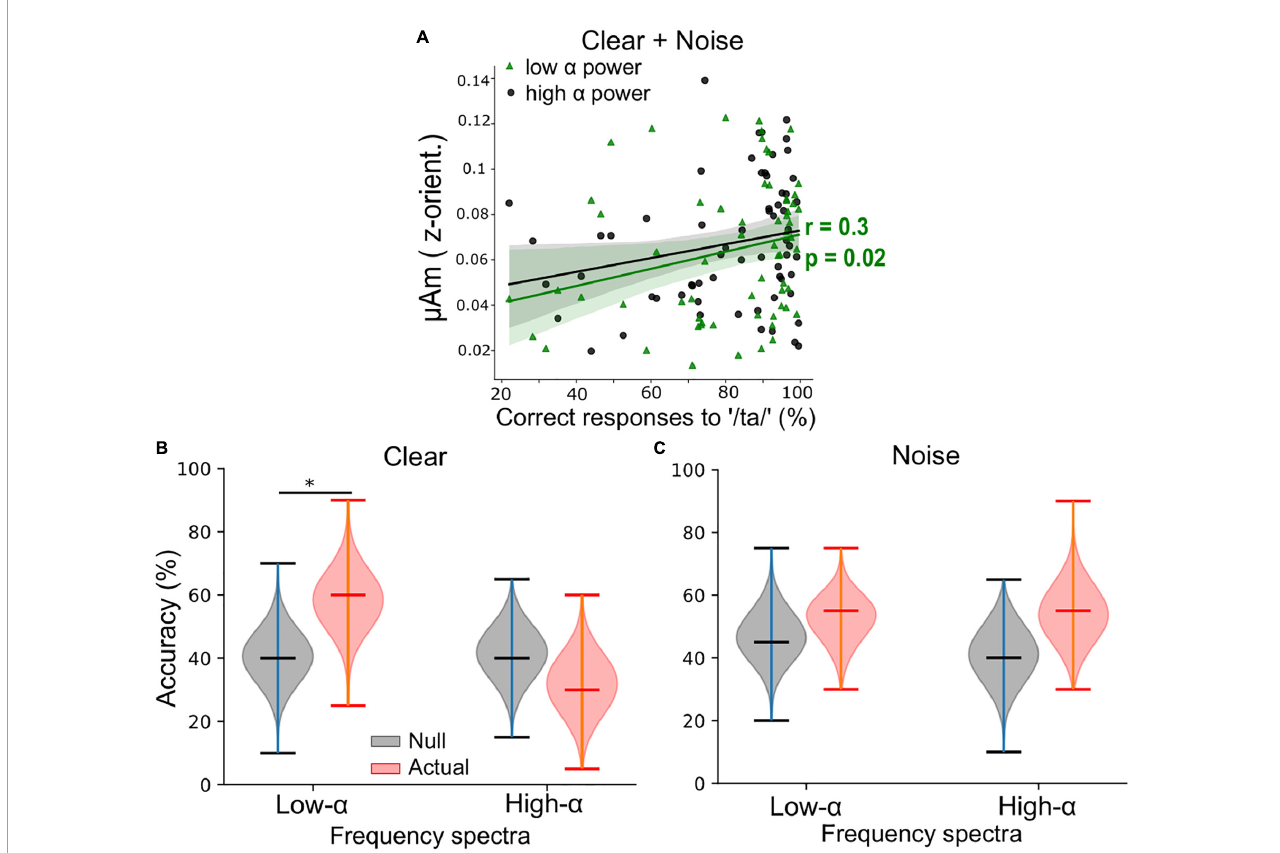
FIGURE3 Low α frequency-following responses (FFRs) better predict behavioral performance than high α FFRs during clear speech perception when pooling across background conditions. (A) Low α FFRs correlated positively with percent correct of speech target detection. r = Spearman’s correlation. Shaded area = 95% CI of the regression line. (B) For clear speech, support vector machine (SVM) classifier accuracy was significantly better using low α (but not high α ) FFR frequency spectra to classify participants perceptual performance level (i.e., poor vs. good) compared to the null classification accuracies. (C) For noise-degraded speech, classification accuracies were similar when using low or high α FFR spectra and did not differ from the null classification accuracies. Upper/lower ticks = max/min; center tick = medians. ∗ p < 0.01.